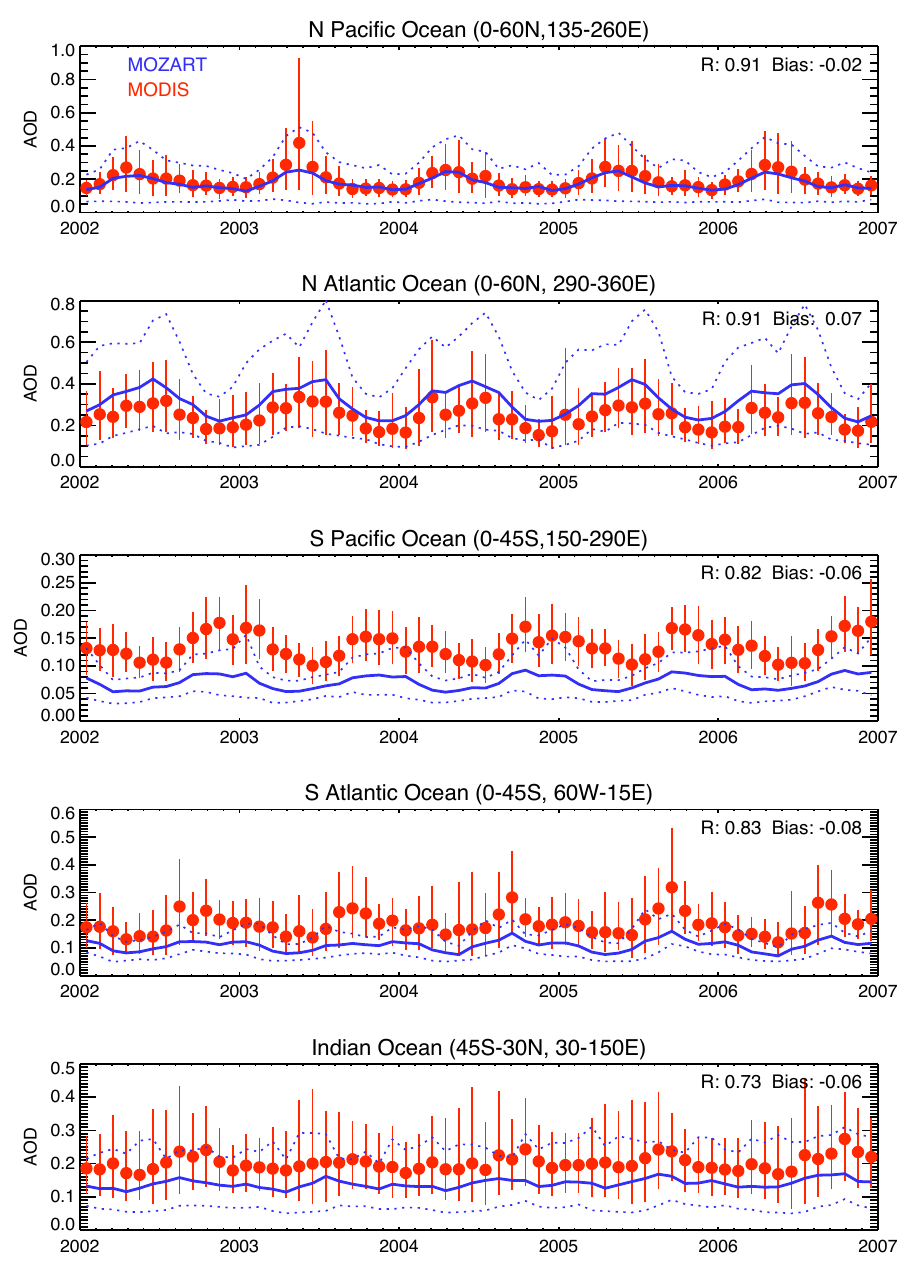
Fig. 9. Evaluation of MOZART-4 AOD with MODIS AOD retrievals. Ocean-only retrievals from MODIS for five regions are compared to ocean-only grid points from MOZART-4 (latitude-longitude ranges indicated in plot titles). Monthly means are shown, with error bars (dotted lines for MOZART-4) indicating the central 80% of the variation over the